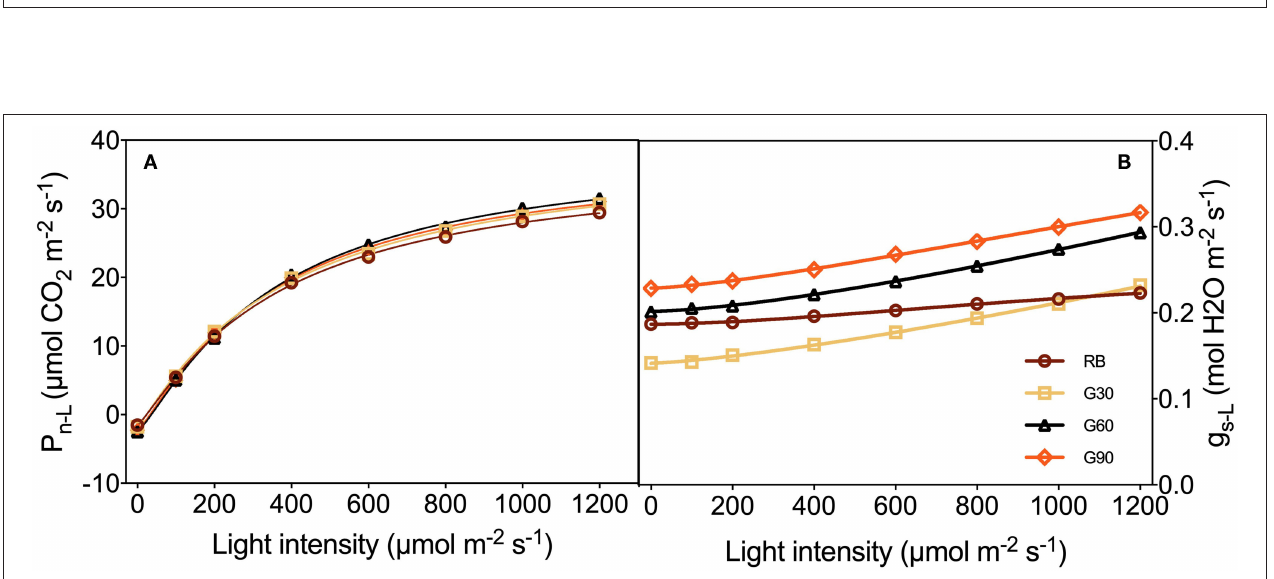
FIGURE 9 | P n − L (A) and g s − L (B) to light intensity response curves as affected by the different proportions of green light.